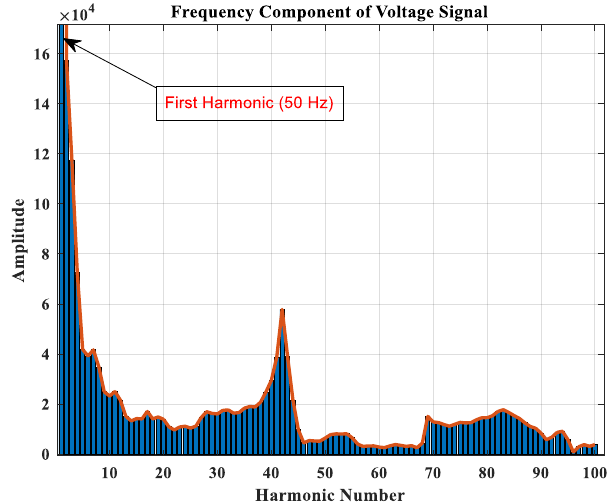
Figure 1. ABC sequence and alpha component of voltage waveform for a sample fault.